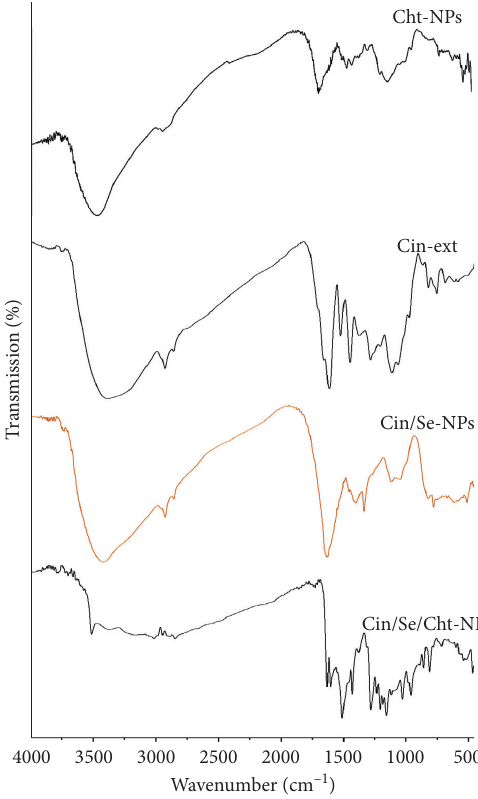
Figure 2: FTIR spectra of plain chitosan nanoparticles (Cht-NPs), cinnamon bark extract (Cin-ext), synthesized selenium nano- particles with cinnamon extract (Cin/Se-NPs), and their nano- composites with nano-chitosan